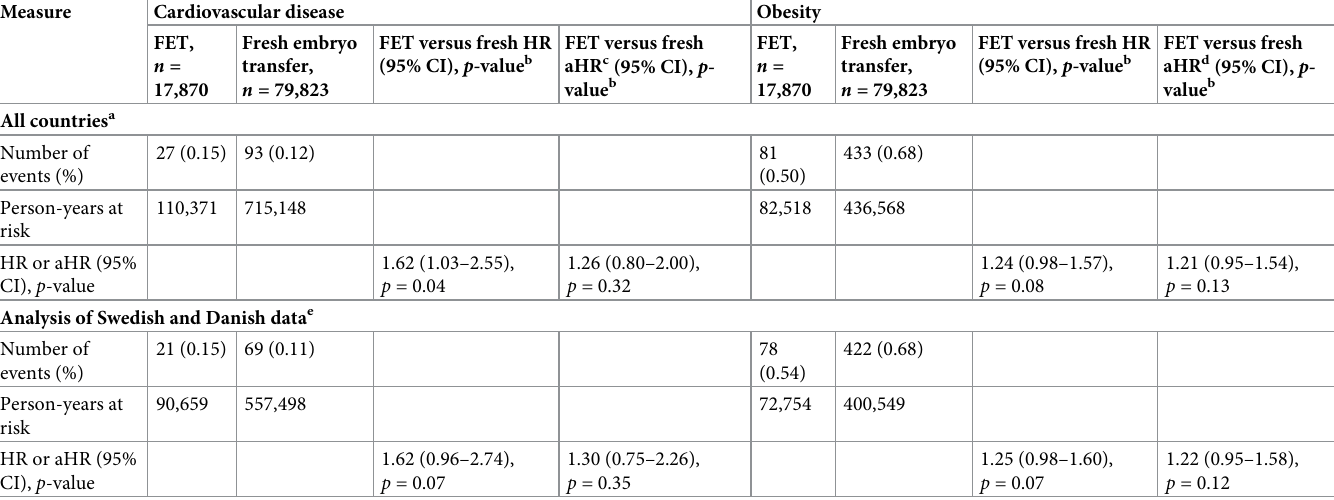
Table 5. Association between frozen embryo transfer and cardiovascular disease and obesity in singletons born in Norway, Sweden and Denmark a between 1984 and 2015. Measure Cardiovascular